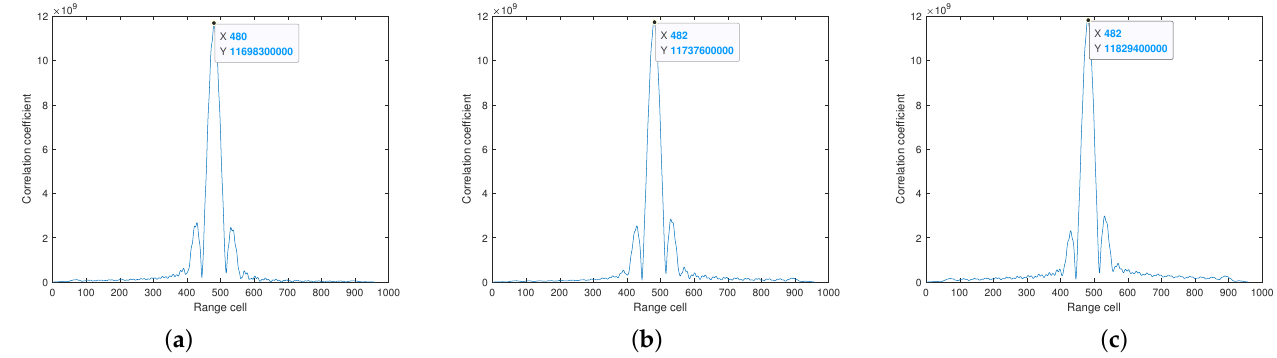
Figure 7. The correlation results: ( a ) the correlation results of the 45th frame and 46th frame; ( b ) the correlation results of the 46th and 47th frames; ( c ) the correlation results of the 47th and 48th frames.